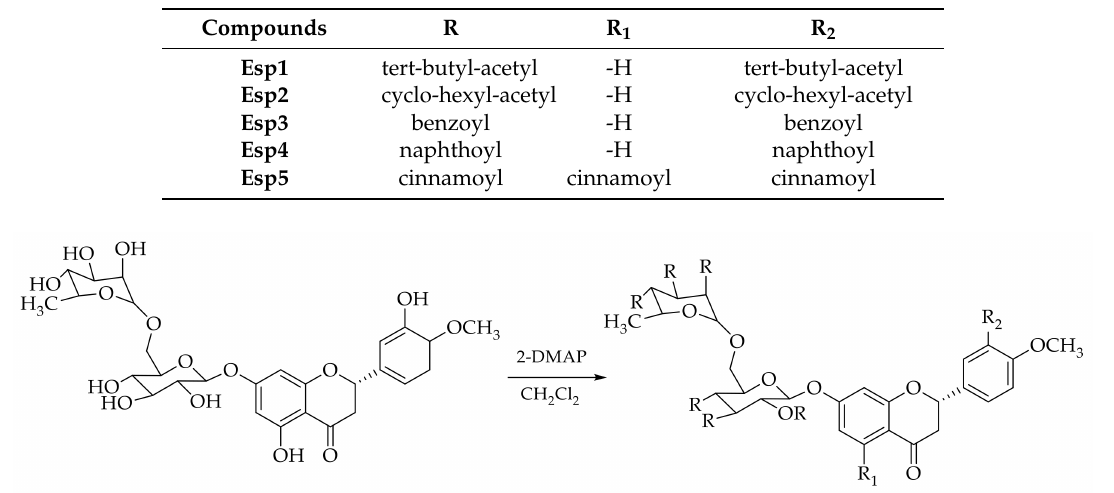
Scheme 1. Synthetic procedure of Esp1–Esp5 .